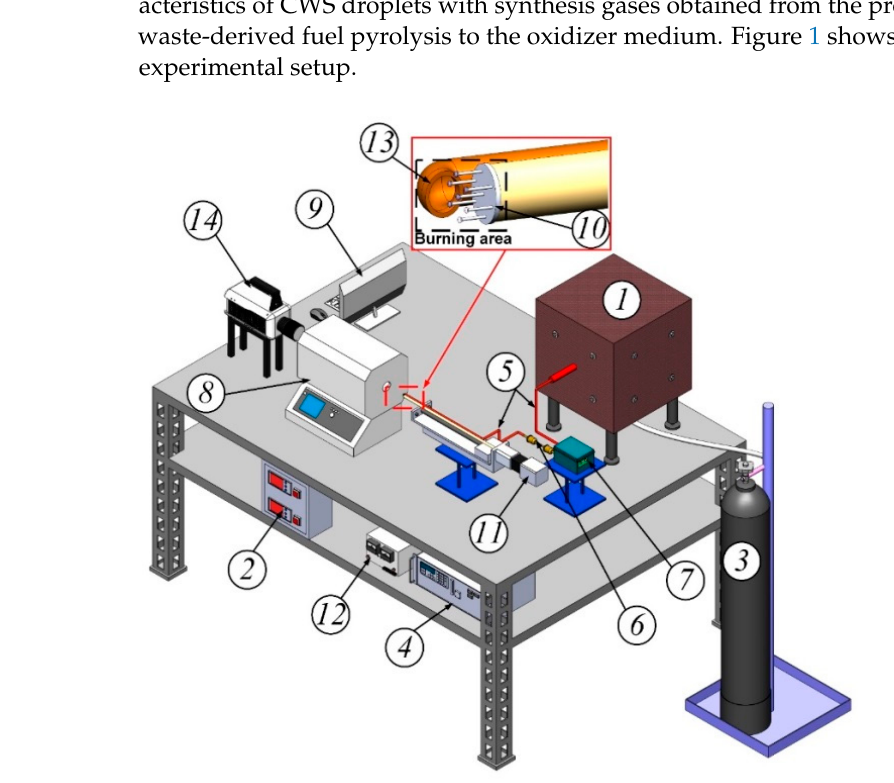
Figure 1. 3D model of the experimental setup: 1—gasifier; 2—controller; 3—compressed nitrogen